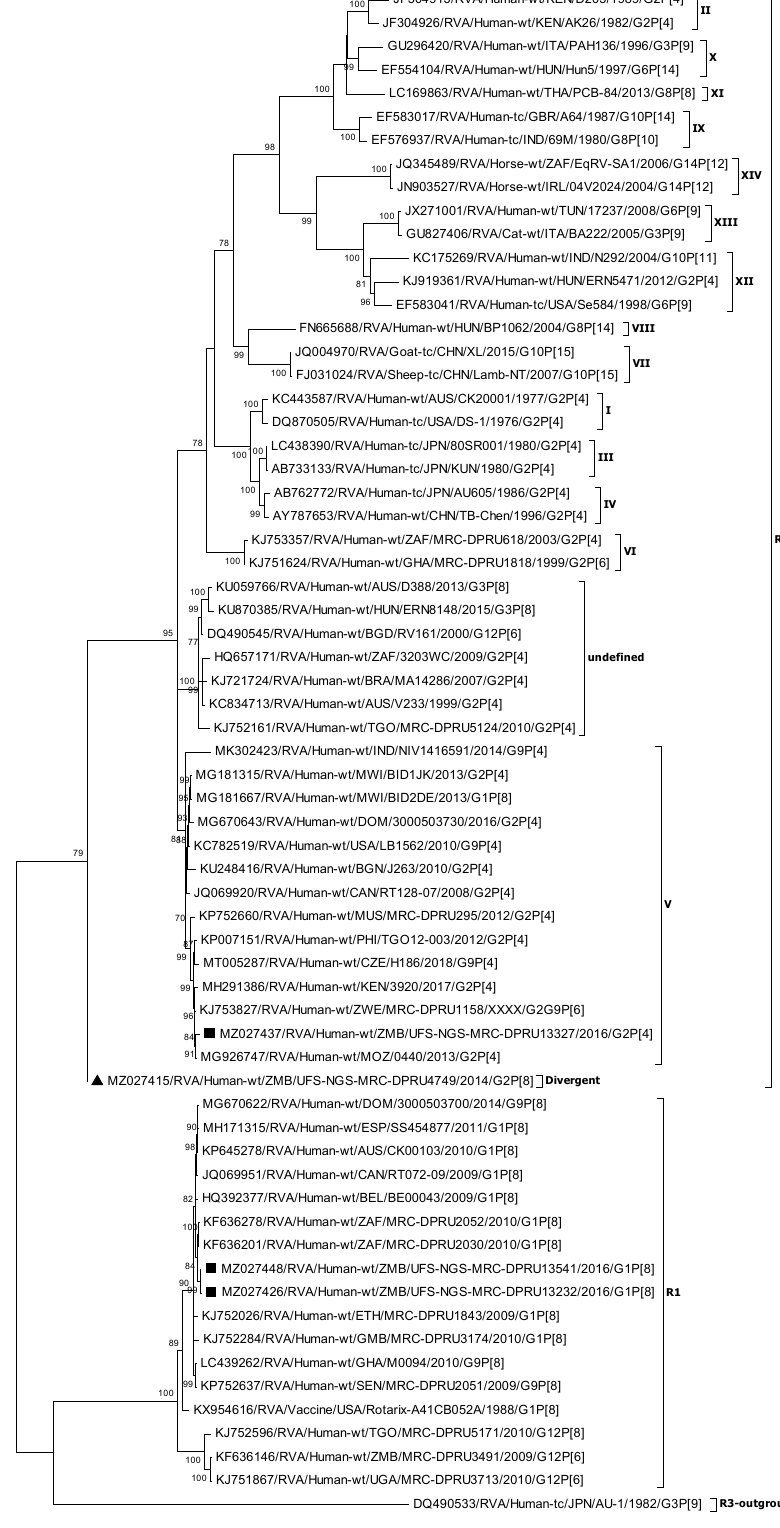
Figure 5. VP1 phylogenetic tree of the Zambian R1 and R2 strains indicated by black squares along with representative Strain UFS-NGS-MRC-DPRU4749, indicated by a black triangle is a divergent strain. Phylogenetic analysis was conducted using the maximum likelihood method with bootstrap values of 1000 replicates. The scale at the bottom indicates the number of nucleotide substitutions per site. Percent values of bootstrap values greater than or equal to 70 is indicated on the branch